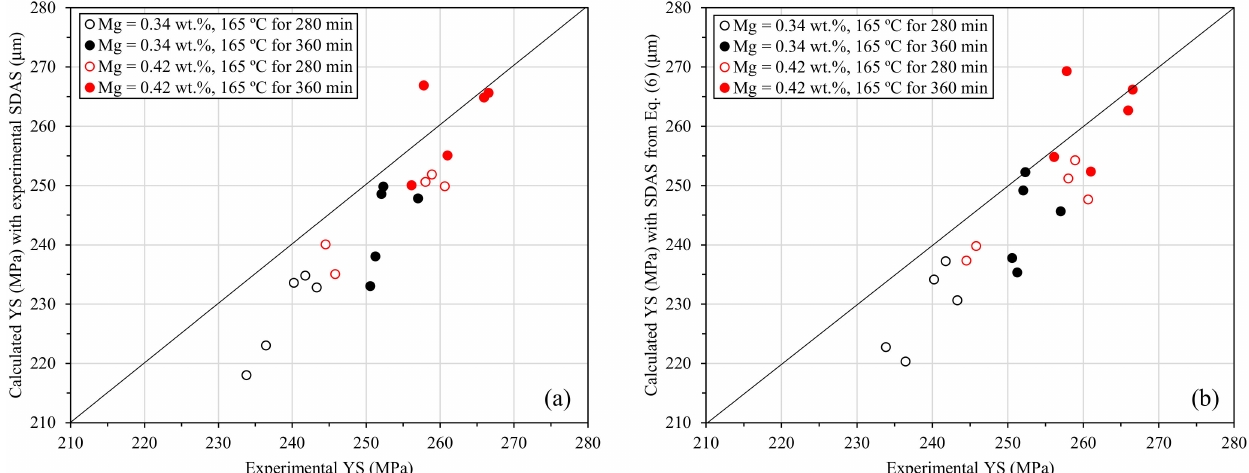
Figure 21. Comparison of experimental YS values obtained from the SK-7 castings and those pre- dicted by using Equation (28) and data included in Table 11. Two different SDAS parameters are used: experimentally measured SDAS ( a ) and the values of this parameter determined with Equation (6) ( b ). Black symbols correspond to SK-7 castings manufactured with 0.34 wt.% Mg while red symbols correspond to castings produced with 0.42 wt.% Mg. In both cases, open and solid circles represent those castings aged at 165 ◦ C for 280 min and for 360 min, respectively. Solid lines are the